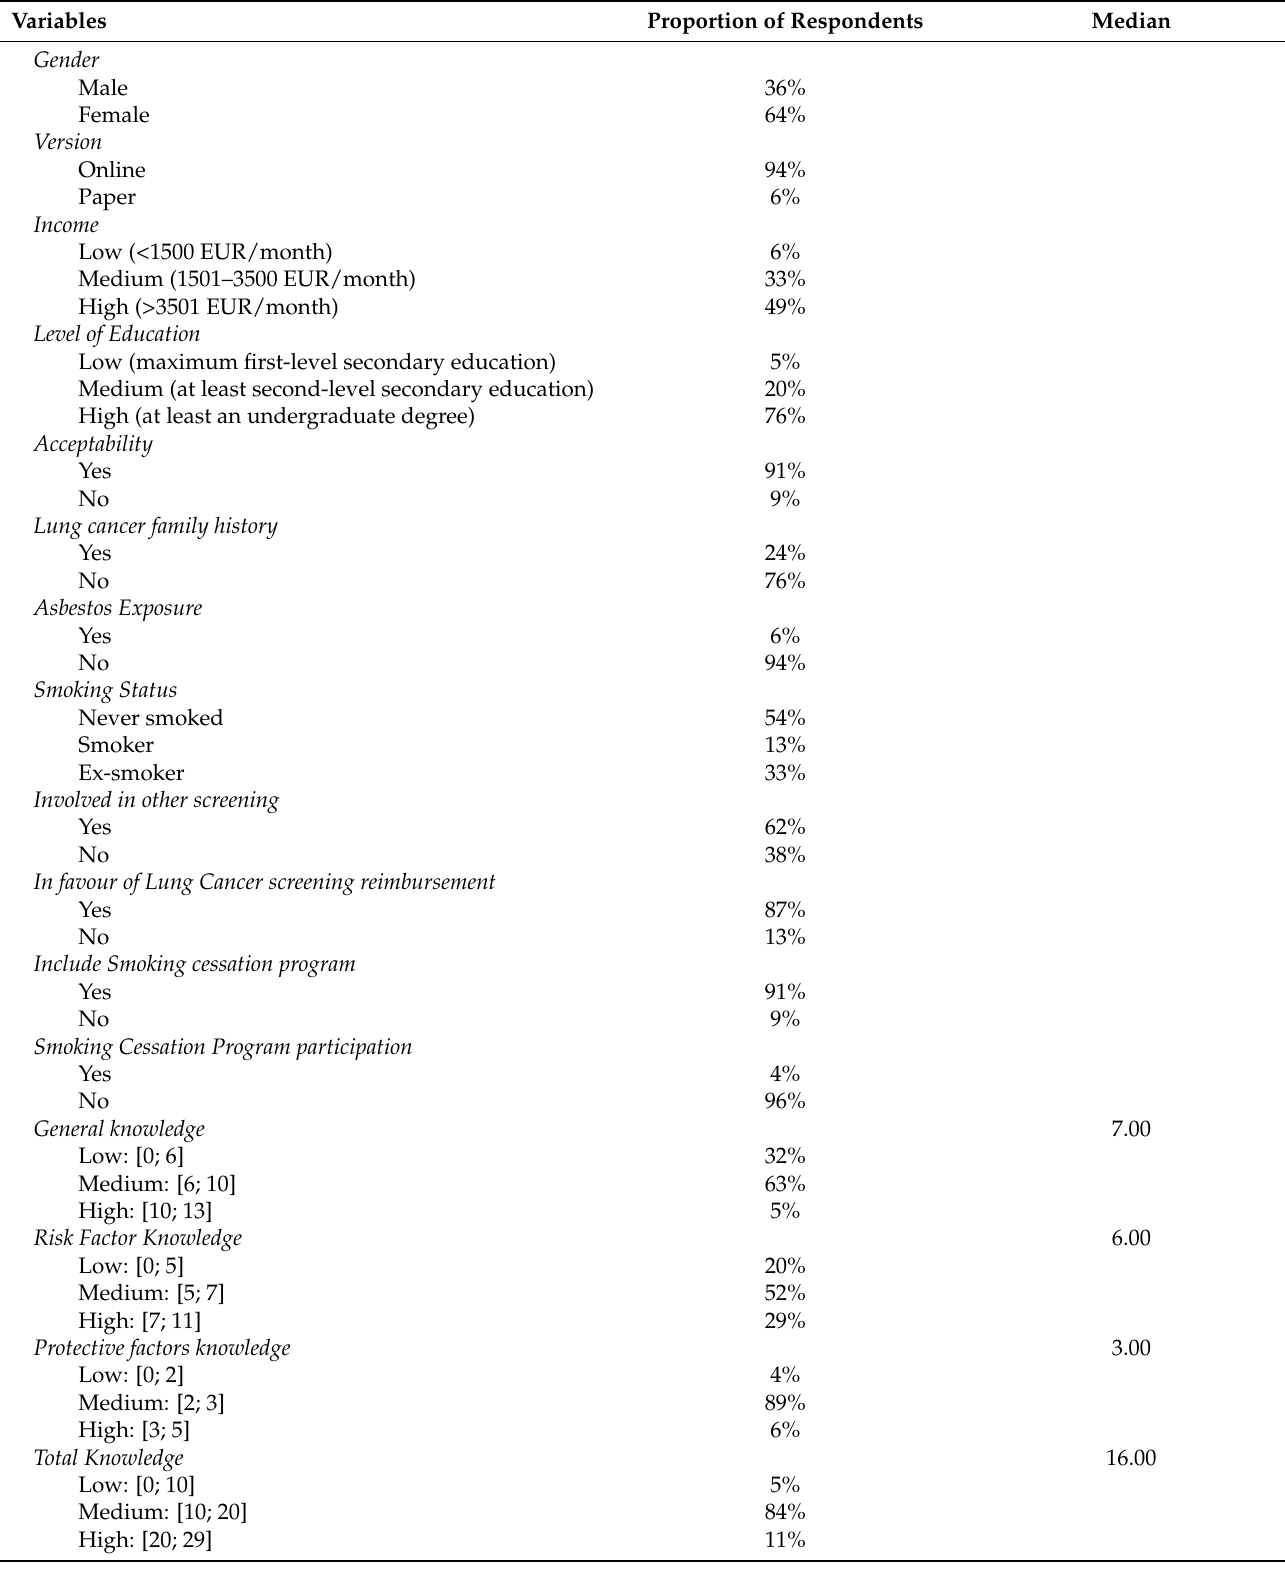
Table 3. Descriptive statistics of variables without missing data collected and used for modelling (n = 487). This table contains the distribution of characteristics linked to the respondents of the survey. The relative proportion of respondents falling within a certain category is